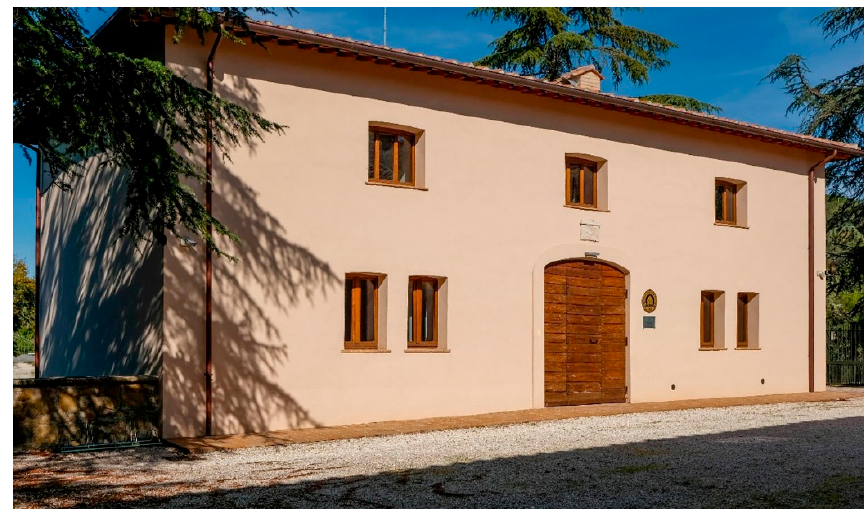
Figure 1. The case study building from the front side. Energies 2020 , 13 , x FOR PEER REVIEW